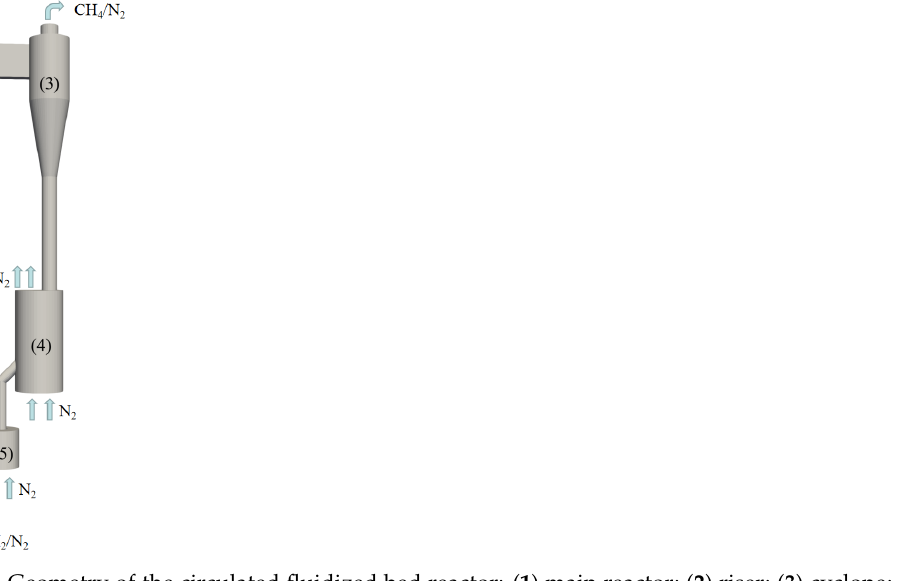
Figure 4. Geometry of the circulated fluidized bed reactor: ( 1 ) main reactor; ( 2 ) riser; ( 3 ) cyclone; ( 4 ) bubbling fluidized bed; and ( 5 )